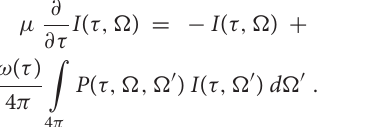
angle, ϑ 0 , is defined as an angle between the positive direction of the z-axis and the direction to the Sun. The x-axis of the basic coordinate system is chosen to point away from the Sun. This means that the azimuthal angle of the solar beam is equal to zero ( ϕ 0 = 0 ◦ ). The intensity of the direct solar light is written as I 0 δ ( µ − µ 0 ) δ ( ϕ − ϕ 0 ), where δ ( µ − µ 0 ) and δ ( ϕ − ϕ 0